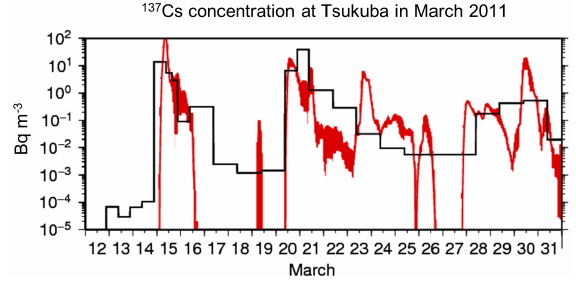
Figure 6. Time series of the surface activity concentration of (black) observed and (red) simulated 137 Cs concentrations at Tsukuba from 12 March to 1 April 2011 (Bqm − 3 ) . The red shaded areas indicate the range of 137 Cs concentrations obtained when the simulations were run using the optimized parameter ranges E c = 0.03–0.05 and v d = 0.05–0.1cms − 1